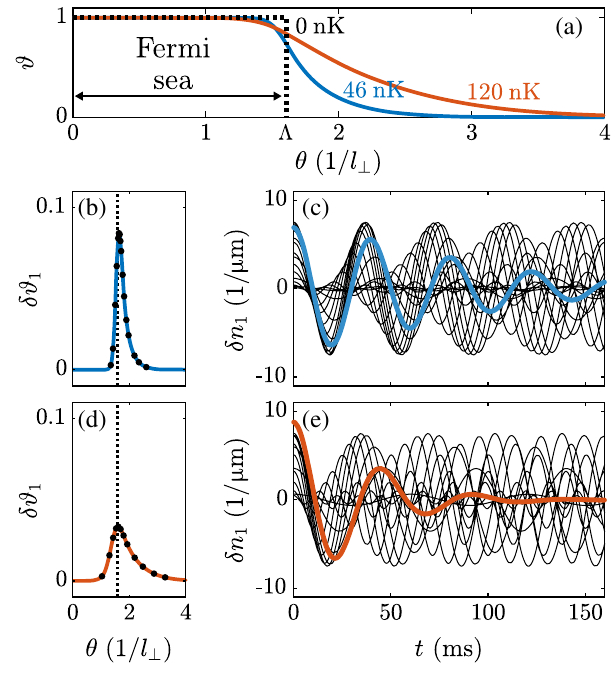
FIG. 4. Relaxation of the excited density mode through dephasing of its rapidity components. (a) Occupation function ϑ ð θ Þ of a thermal state with density n ¼ 65 μ m − 1 computed for the ground state ( T ¼ 0 nK) and for temperatures corresponding to the small quench amplitude experimental realizations of Fig. 2. The occupation function is an even function of rapidity; therefore, only positive rapidities are plotted here. (b),(d) j ¼ 1 cosine mode of the occupation function δϑ 1 ð θ Þ of the low- and high- temperature realizations, respectively. The dashed line indicates the Fermi momentum Λ of the zero-temperature state. The black dots mark select rapidities θ , and the corresponding evolutions of i δϑ θ are plotted as thin, black lines in (c),(e). For reference, the 1 ð i Þ simulated mode density δ n 1 ð t Þ is plotted on top. Note that in (c), (e) the amplitudes of δϑ 1 ð θ are scaled to match δ n 1 i Þ